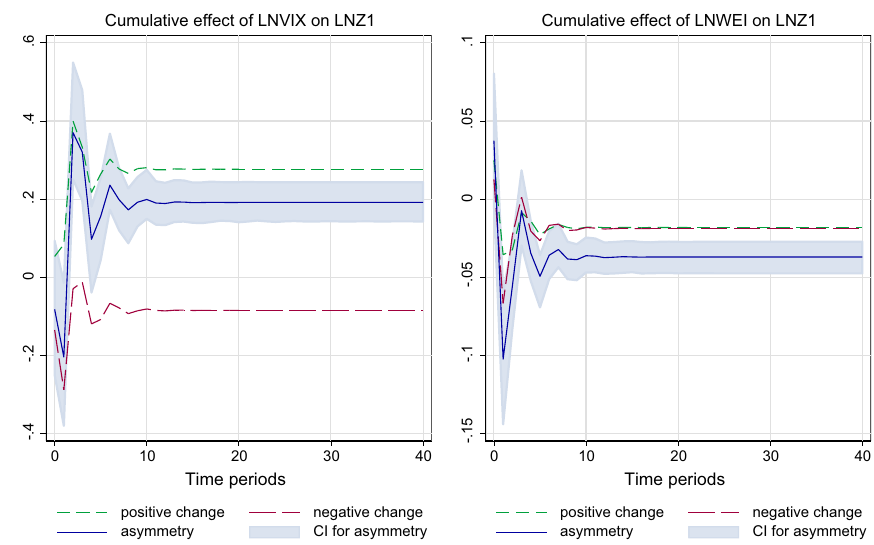
Fig. 1 Cumulative effects of LNVIX and WEI on Food Insecurity ( LNZ 1